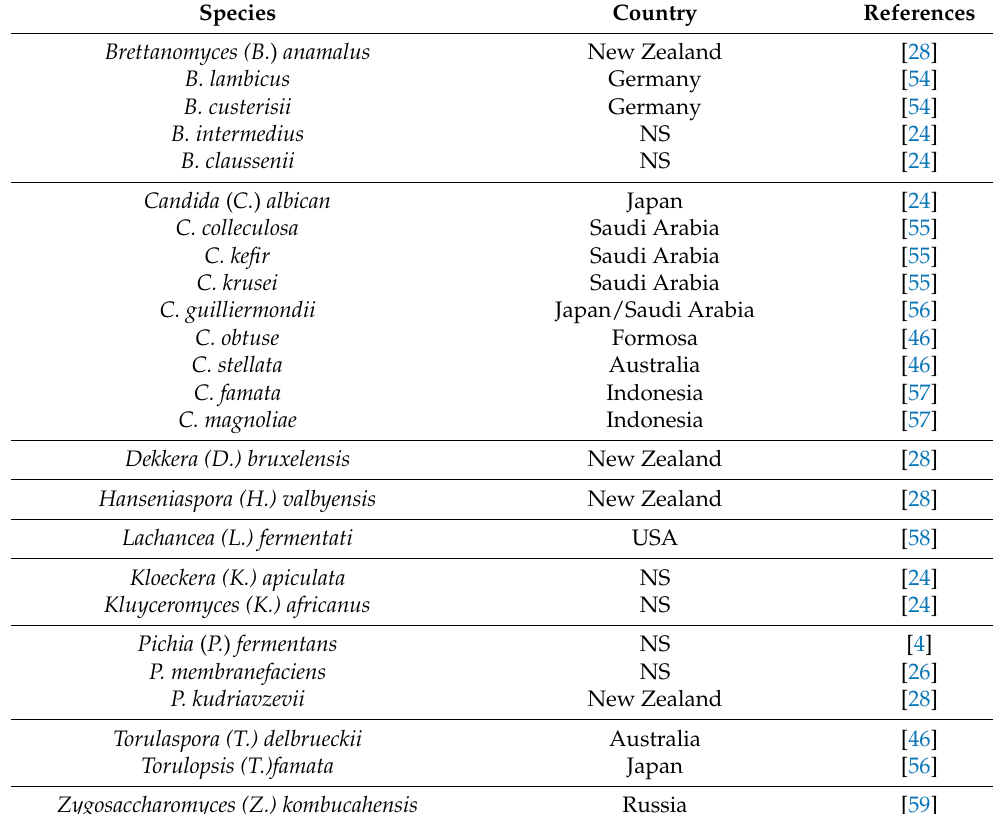
Table 4. Yeast isolated from Kombucha in different